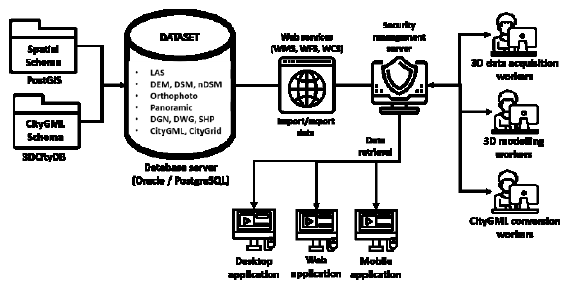
Figure 22: The system architecture for spatial database and other sub-systems